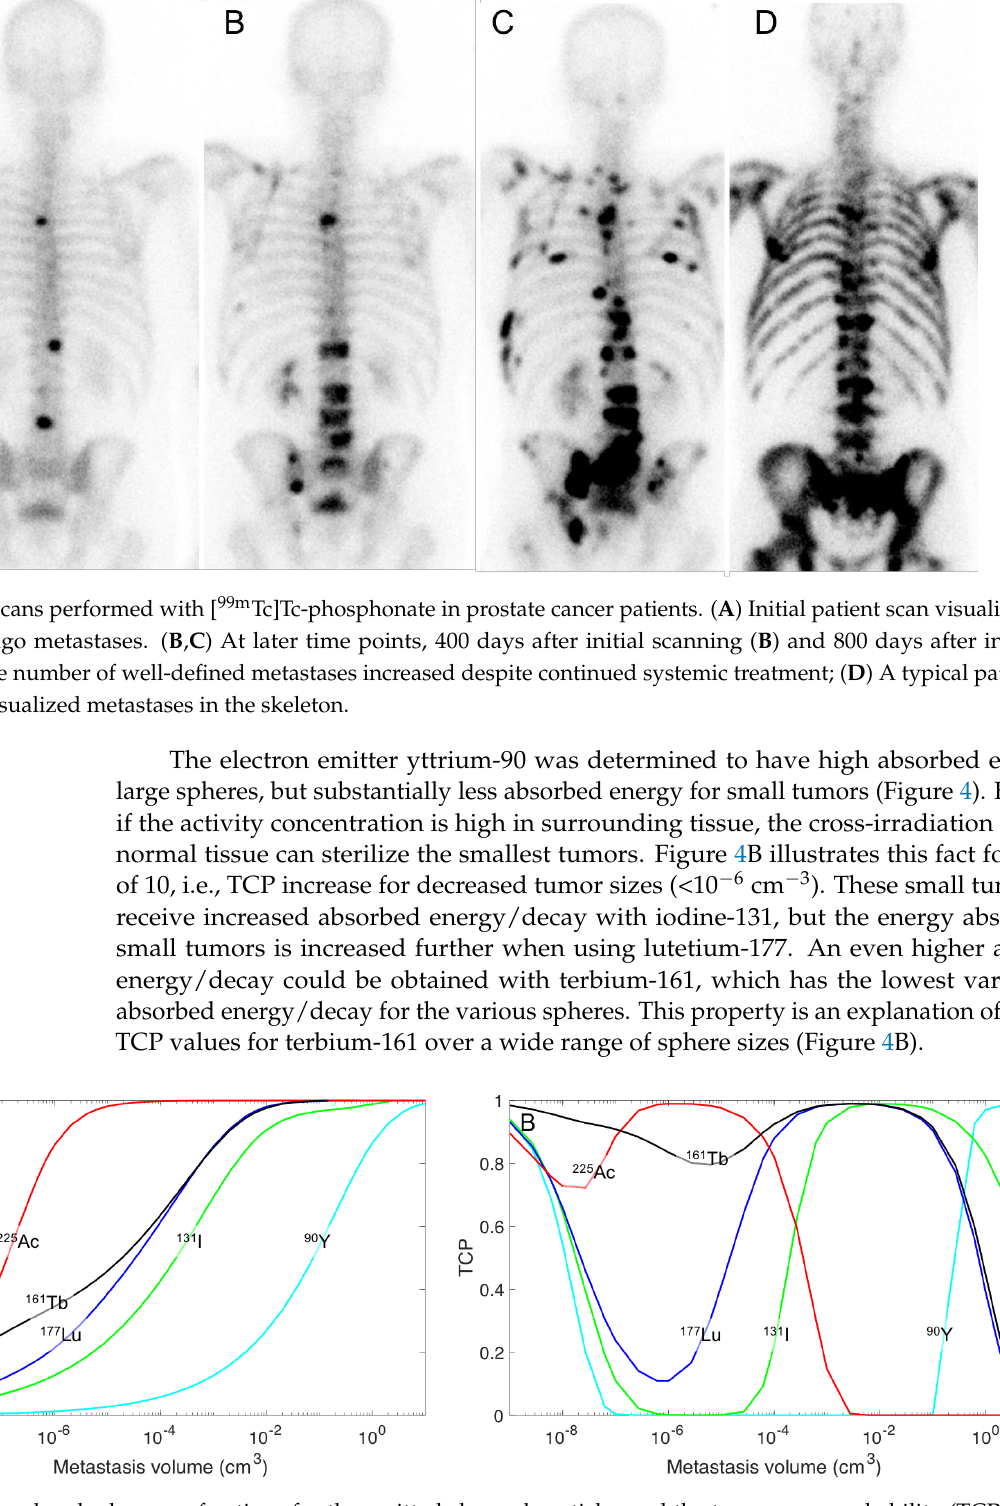
Figure 4. ( A ) The absorbed energy fractions for the emitted charged particles and the tumor cure probability (TCP) for ytterium-90 (cyan), iodine-131 (green), lutetium-177 (blue), terbium-161 (black), and actinium-225 (red) in spherical tumor volumes with homogenous activity distribution. ( B ) Graph shows the TCP curve for the activity concentration that generates an optimal TCP = 0.99, and a TNC = 10, for the sphere masses of 10 −9 (one cell) to 100 g.